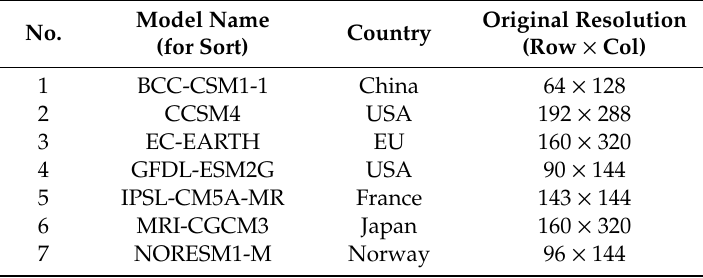
Table 1. Brief introduction to the CMIP5 (phase 5 of the Coupled Model Inter-comparison Project) models.